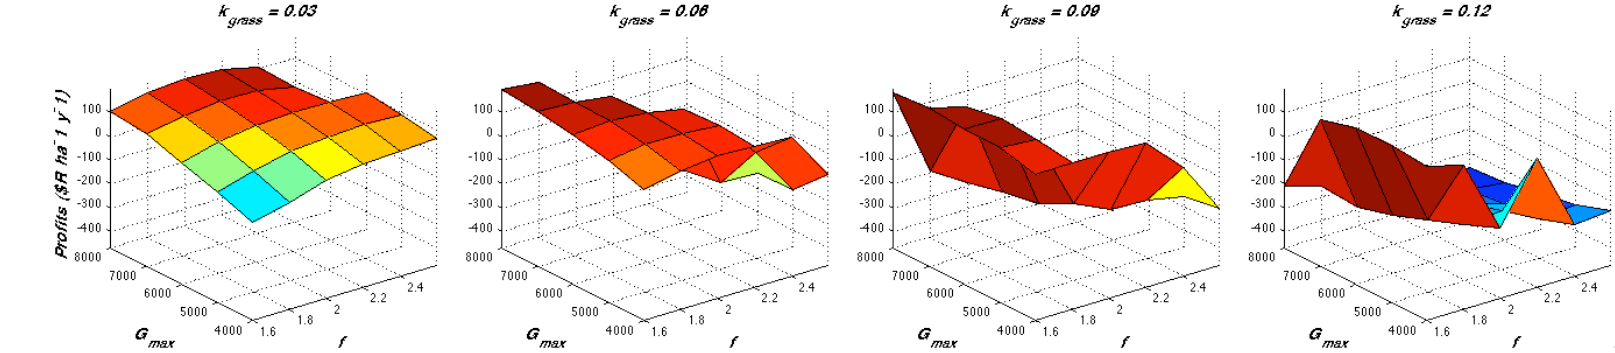
Figure A2.2: Average cattle density (head/ha) across dimensions of grass capacity G growth rate k (/t). Individual surfaces show average cattle density as a function of grass capacity and stocking factor f at a constant intrinsic grass grass growth rate.